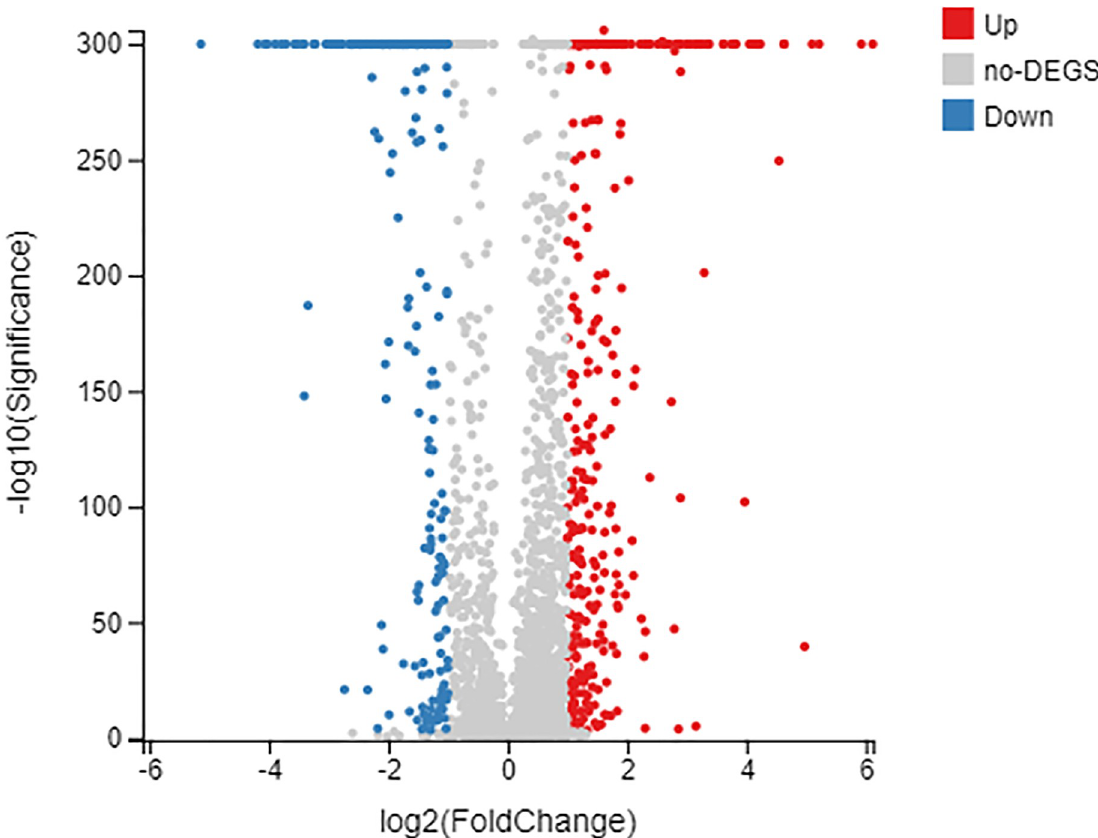
Fig 2. Differentially expressed genes identified by transcriptome analysis of low-level rifampicin.